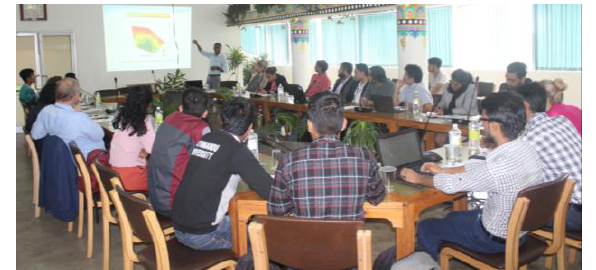
Figure 3. Workshop on Fit 4 Purpose (Department of